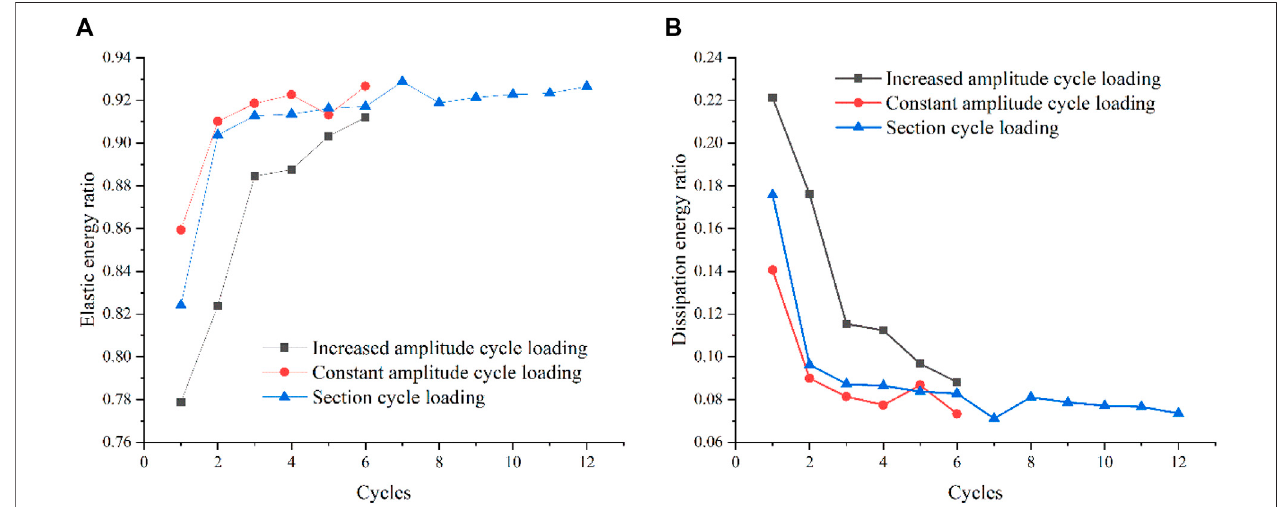
FIGURE12| Changesintheproportionofelasticenergyanddissipatedenergywiththenumberofcyclesfordifferentstresspaths. (A) Changeoftheelasticenergy ratio with the number of cycles; (B) The proportion of dissipated energy changes with the number of cycles.